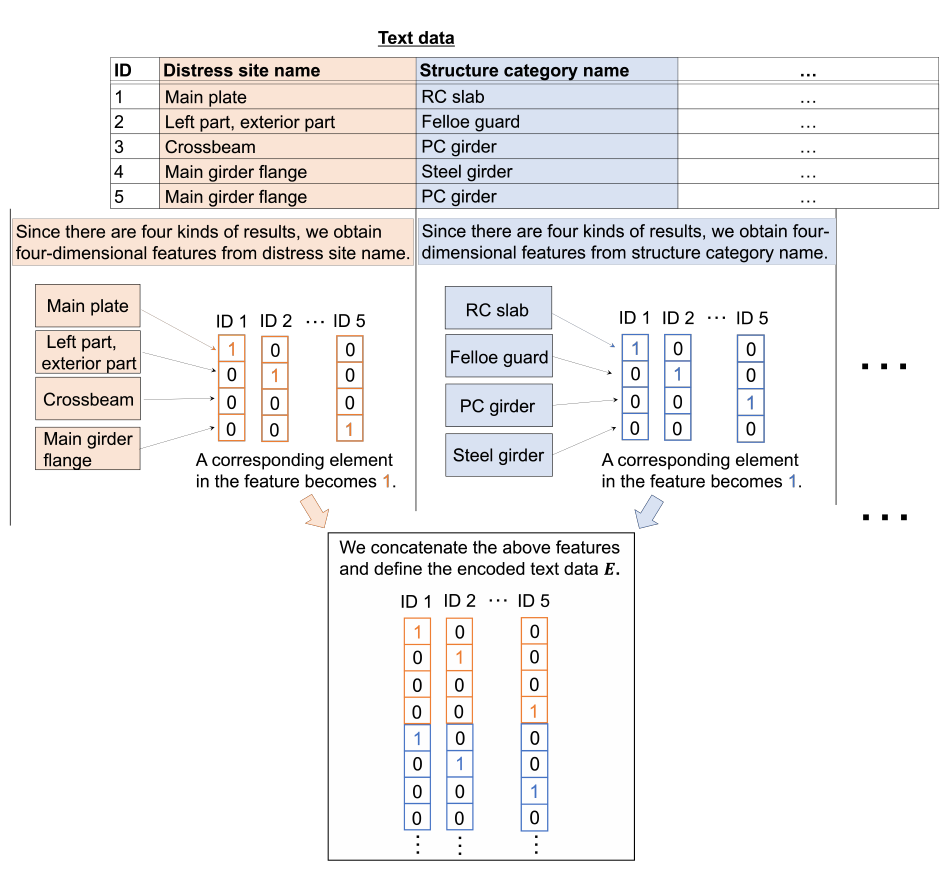
Figure 2. Details of the encoding approach for the text data. In the case of M = 5, each sample is assigned to IDs 1 to 5. As shown in “Distress site name,” there are four kinds of inspection results; hence, we obtain four-dimensional features for this item. ID1 has a main plate as “Distress site name”, and the corresponding element in the feature becomes 1, and the other elements become 0. Finally, the obtained features are concatenated for each ID, and the encoded text data E are defined. This encoding approach is based on the studies